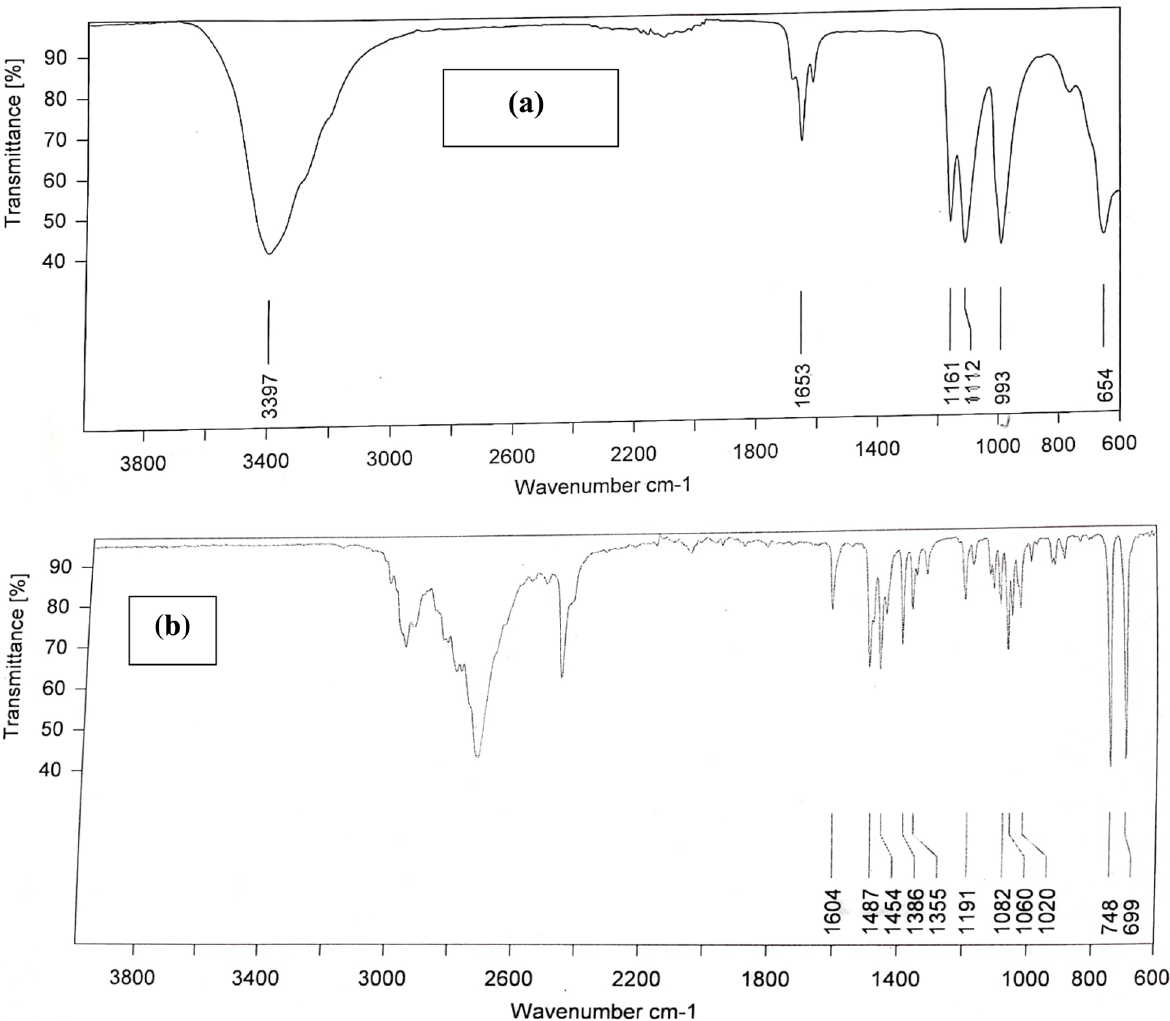
Fig. 2 FTIR spectra represent a wavenumber of samples having sodium thiosulfate ( a ) and represent wavenumber of drug methamphetamine ( b